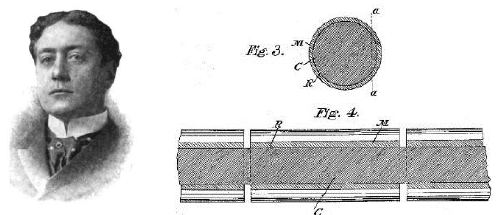
Fig. 2. John Stone Stone (1905) and the design of his bimetallic iron-copper cable